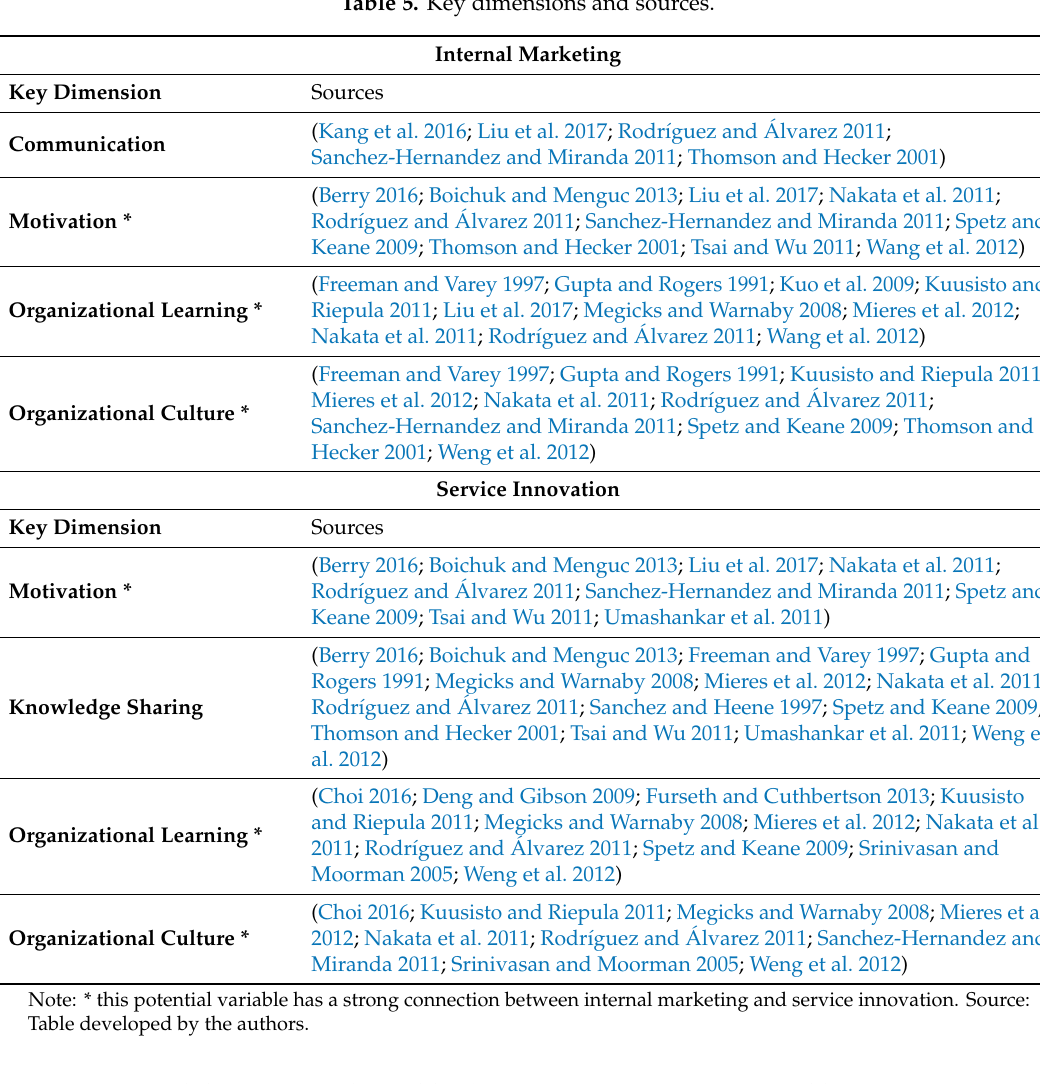
Table 5. Key dimensions and sources.